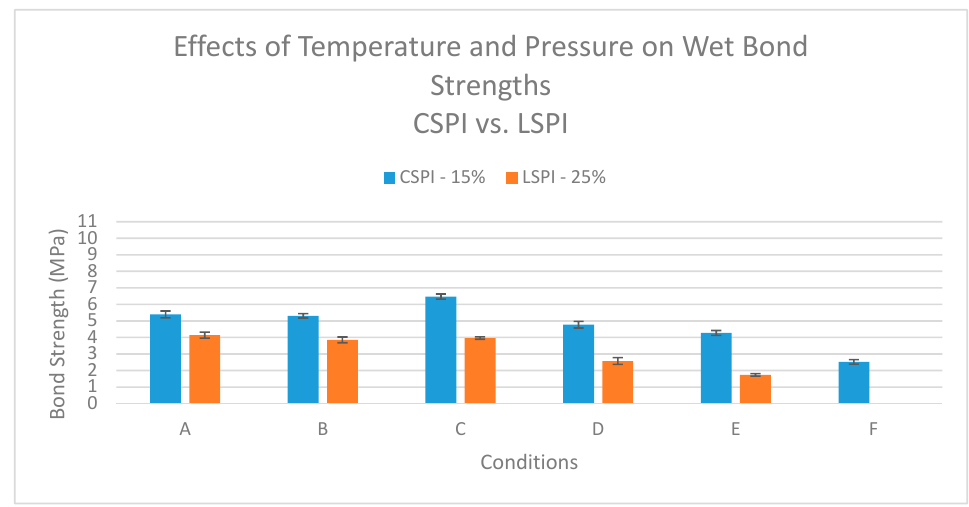
Figure 4. Wet shear strengths of CSPI and LSPI adhesive with maple veneer bonded under different conditions (defined in Table 1).